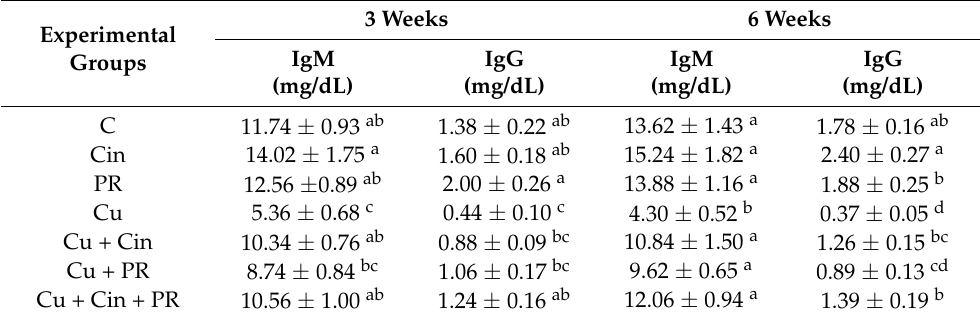
Table 4. Serum levels of IgM and IgG in control and experimental groups at 3 and 6 weeks.